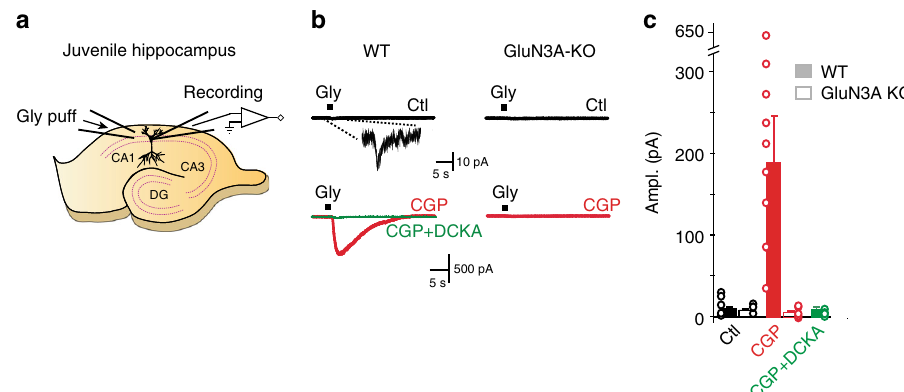
Fig. 5 GluN1/GluN3A receptors are expressed and functional in juvenile hippocampal slices. a Schematic representation of the experimental protocol. Glycine (10 mM) is puffed onto voltage-clamped CA1 cells in acute hippocampal slices from young (P8-12) mice. b In control conditions, glycine puffs trigger very small inward currents in both wild-type (WT) and GluN3A-KO mice (upper black traces on both left and right). A typical response obtained in WT mice is shown at larger magni fi cation and time scale in the top left inset. Bath application of CGP-78608 (CGP) leads to massive potentiation of glycine-elicited currents in WT mice, but has no effect in GluN3A-KO animals (bottom red traces). In WT mice, addition of DCKA (500 µ M), a GluN1 and GluN3A glycine-binding site antagonist, eliminates currents obtained in the presence of CGP-78608 (bottom left green trace), thus further con fi rming that GluN1/GluN3A receptors mediate the responses to glycine. c Quanti fi cation of the experimental results obtained in panel b . WT mice, full bars; GluN3A- KO mice, empty bars. Data are illustrated as mean ±